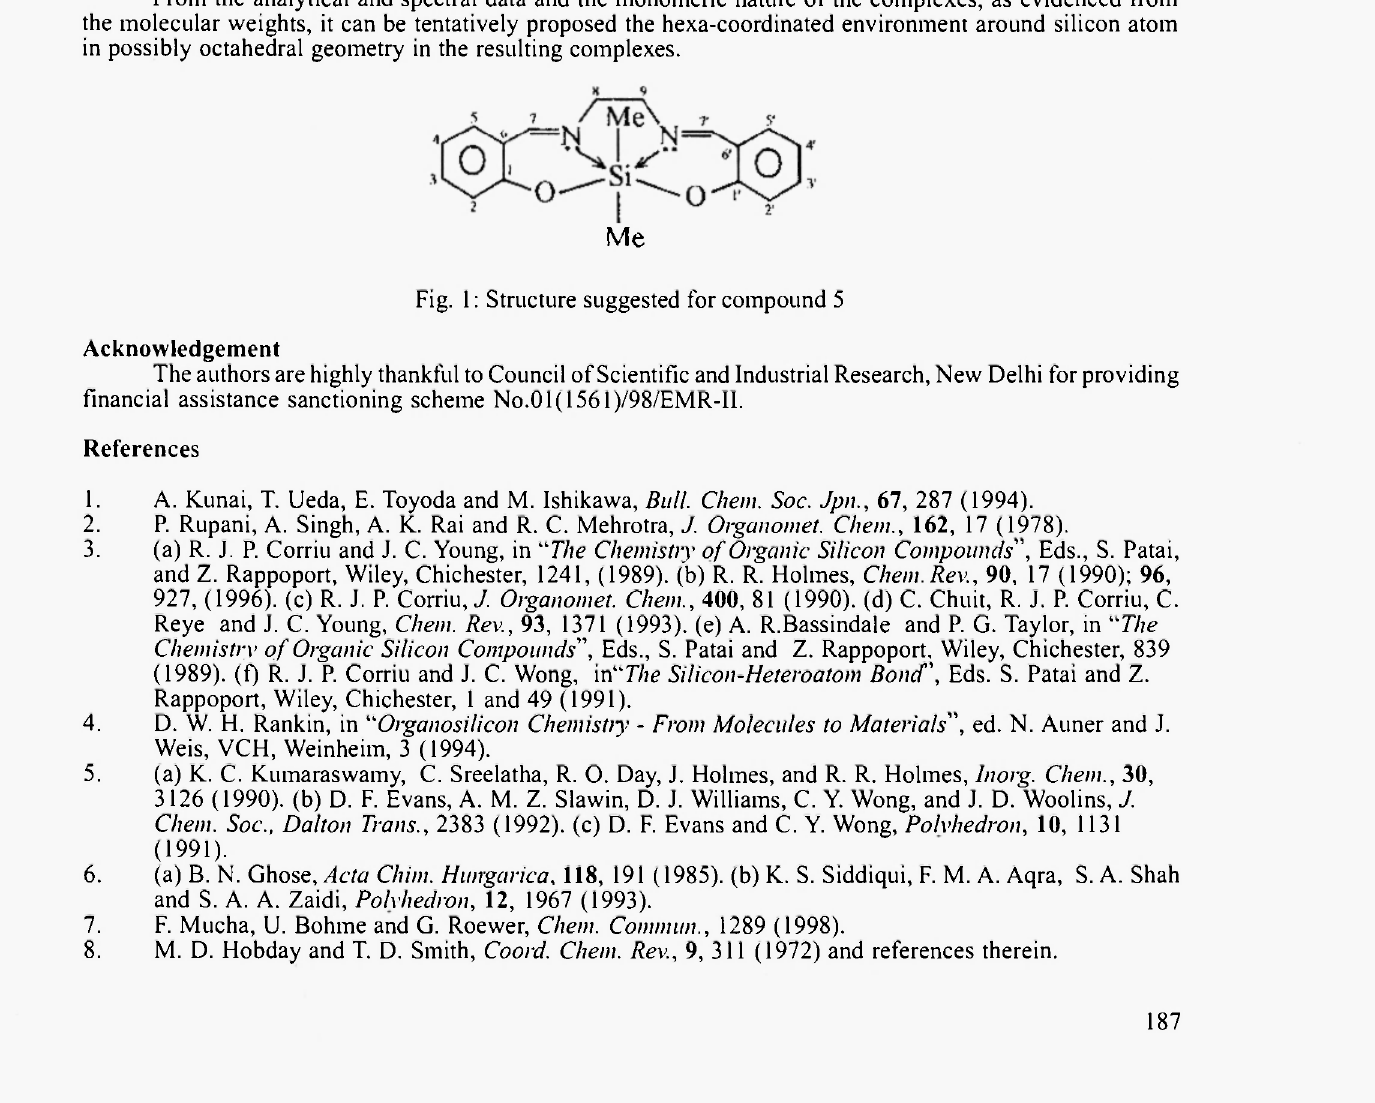
Fig. 1: Structure suggested for compound